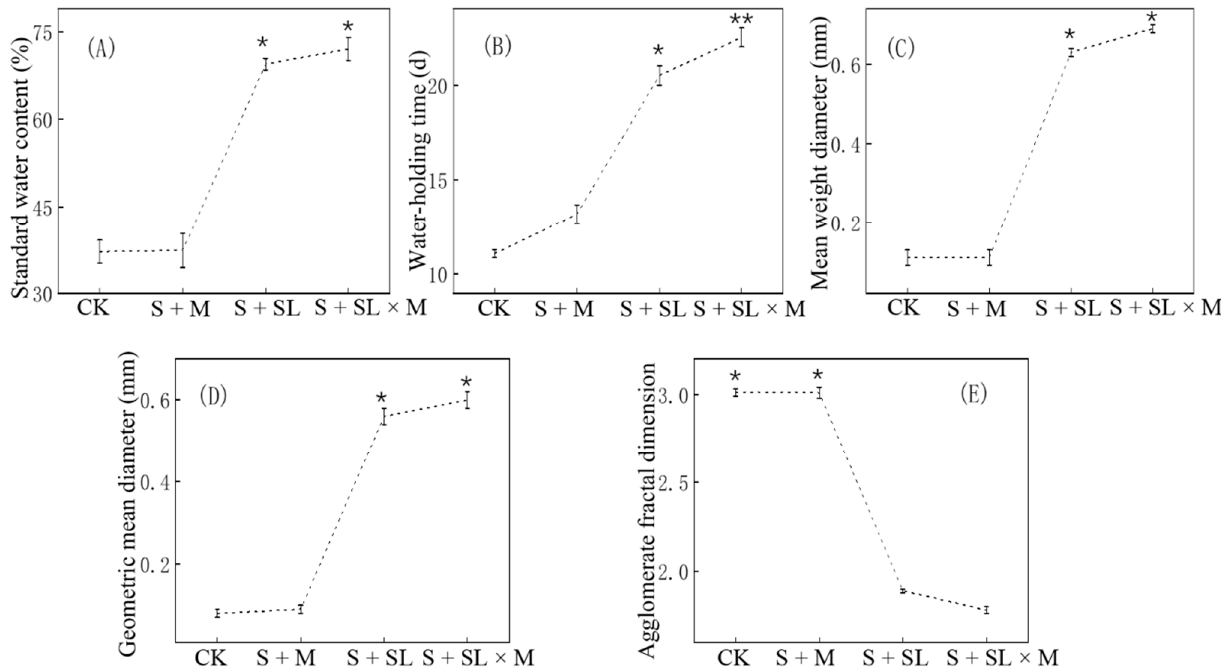
Figure 2. Changes in physical properties of the soil after the addition of water-jet loom sludge and/or a microbial agent; ( A ) saturated water content of differently treated soil; ( B ) water-holding time of differently treated soil, thus reflecting the soil’s water-holding capacity; ( C ) mean weight diameter of differently treated soil; ( D ) geometric mean diameter of differently treated soil; ( E ) soil agglomerate fractal dimension. CK refers to the untreated mining soil samples, S + M refers to the mining soil samples with the microbial agent, S + SL refers to the mining soil samples with water-jet loom sludge samples mixed at a ratio of 2.5:1, and S + SL × M refers to the mining soil samples with water-jet loom sludge samples and the microbial agent. Asterisks indicate statistically significant differences (* represents p < 0.05. ** represents p < 0.01).